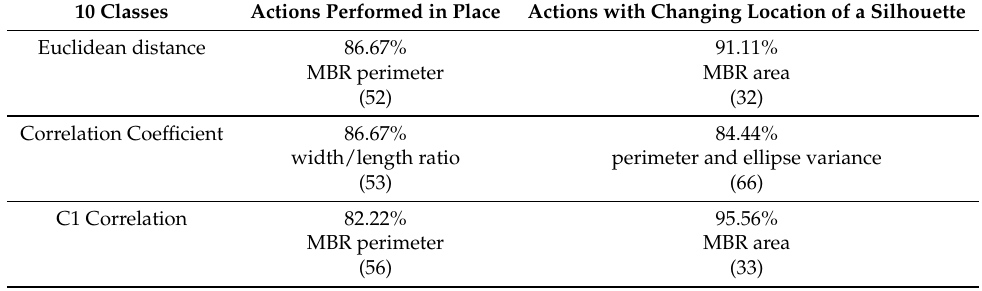
Table 2. Experimental results for the Weizmann dataset used as a benchmark, presented separately for actions performed in place and actions with changing location of a silhouette. The highest accuracy values are listed with the indication of the applied simple shape descriptor and the size of an action representation (given in